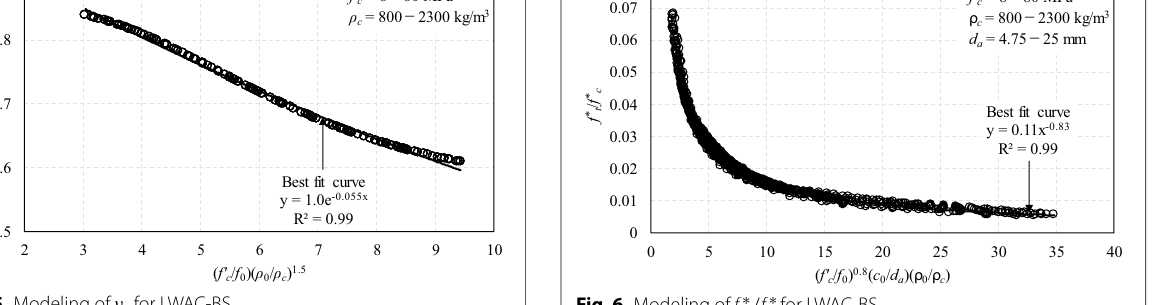
Best fit curve y = 0.11x -0.83